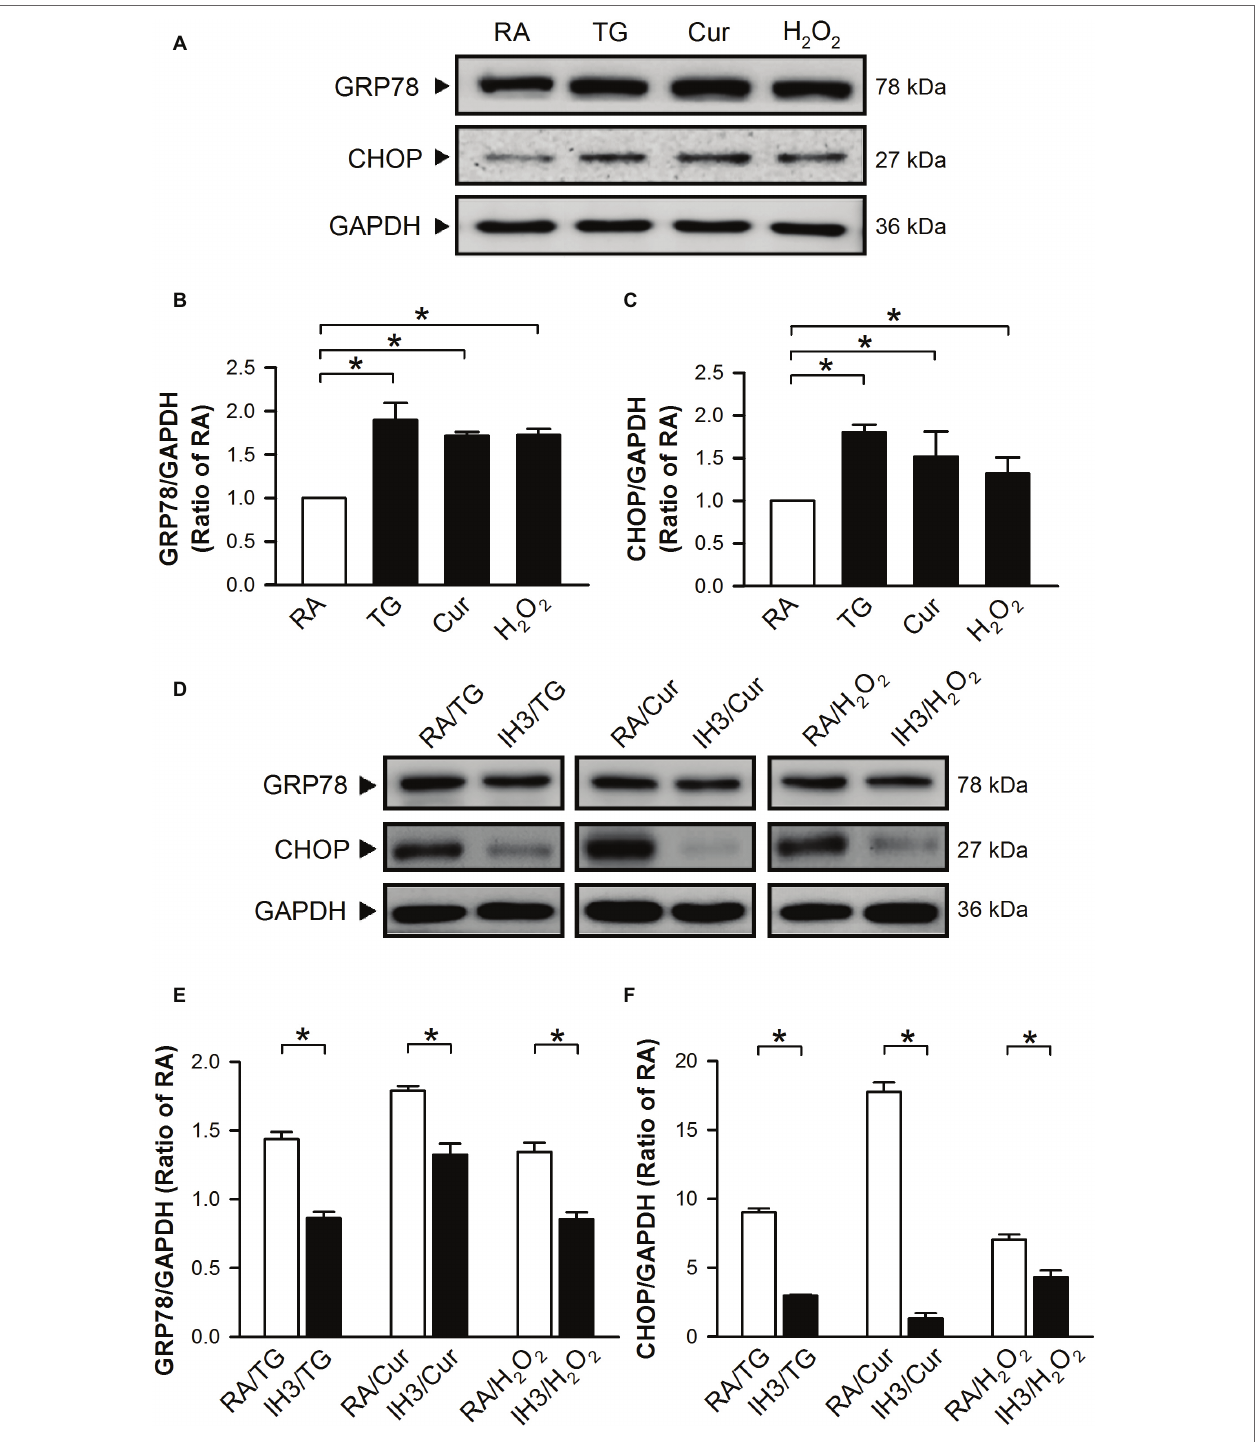
FIGURE 2 | IH reduces the thapsigargin-, curcumin-, or H 2 O 2 -induced increases of ER stress in H9c2 cells. Cells were treated with TG (1 μM; 5 h), Cur (35 μM; 24 h), or H 2 O 2 (100 μM; 24 h) (A–C) or with IH for 3 days followed by TG (5 h), Cur (24 h), or H 2 O 2 (24 h) (D–F) , and then harvested for detecting the GRP78 and CHOP protein levels. (A) A representative result of GRP78, CHOP, and GAPDH protein levels determined by Western blot analyses. Quantitative results shown in (B) for GRP78 protein levels and (C) for CHOP protein levels were adjusted with GAPDH protein levels and expressed as ratio over the RA group. (D) A representative result of GRP78, CHOP, and GAPDH protein levels in RA-exposed or IH-exposed cells determined by Western blot analyses. Quantitative results shown in (E) for GRP78 protein levels and (F) for CHOP protein levels were adjusted with GAPDH protein level and expressed as ratio over the RA group. Values are means ± SEMs ( n = 4). * p < 0.05. Cur, curcumin; ER, endoplasmic reticulum; IH, intermittent hypoxia; RA, room air; TG,